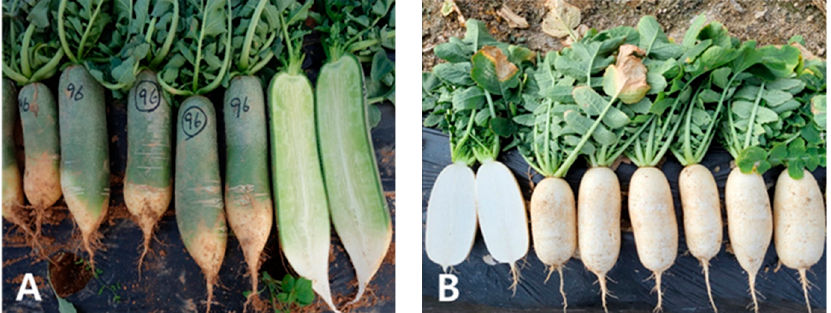
Figure 1. Photograph of ( A ) green-colored radishes; and ( B ) white-colored radishes.